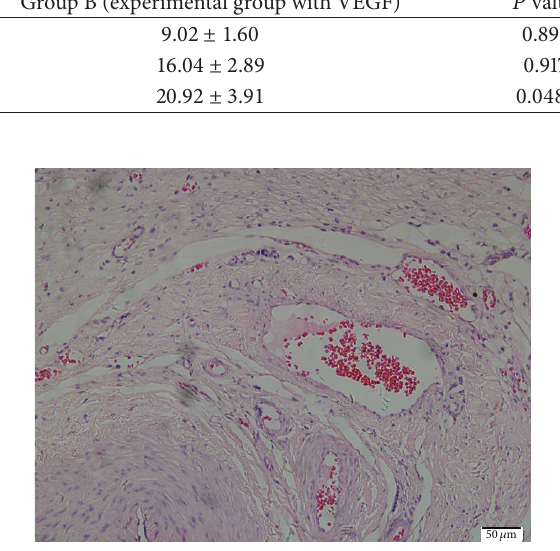
Figure 3: HE staining of specimens 10 weeks after implantation (magnification × 200) showed arteriogenesis: new collateral vessels formed around ligation AV